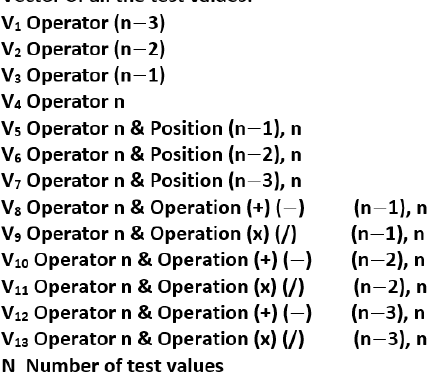
Figure 1. Mental Workload Program block diagram.